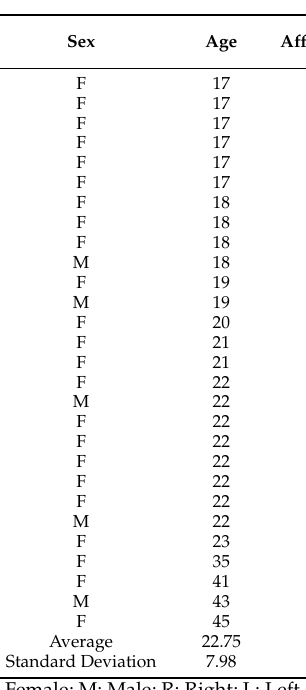
Table 6. Distribution of variables of subjects with UCH between 17 and 45 years